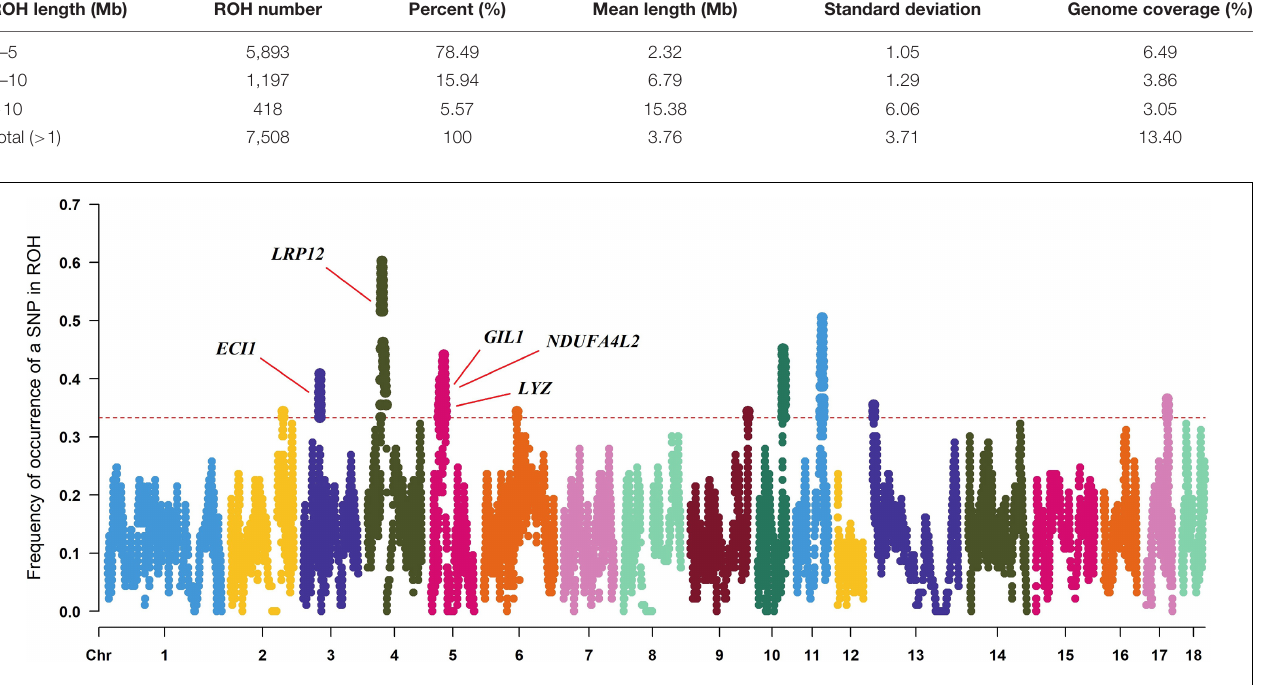
FIGURE 3 | Frequency of occurrences of each SNP within ROH regions among all of the individuals. Horizontal red line represents the 33% threshold. Genes related to meat quality have been